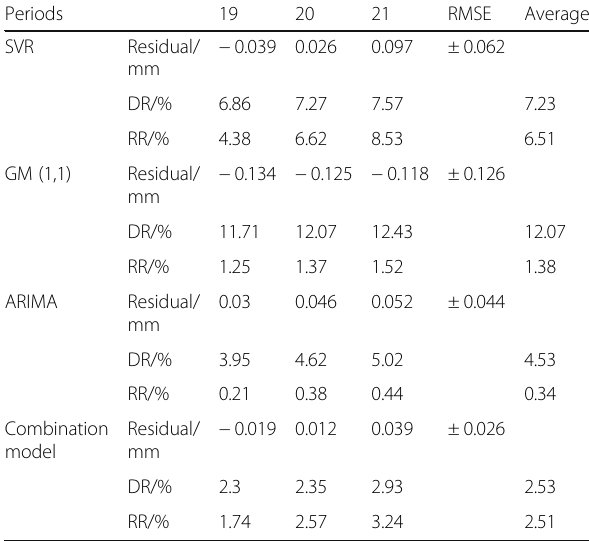
Table 4 Comparison of the effect of single-item model and the